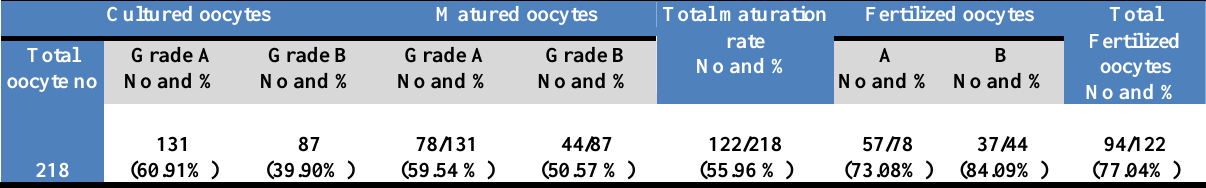
Table, 2: Maturation rate of grade A and B oocytes of slaughtered local goats and IVF rate using sperms obtained by swim-up